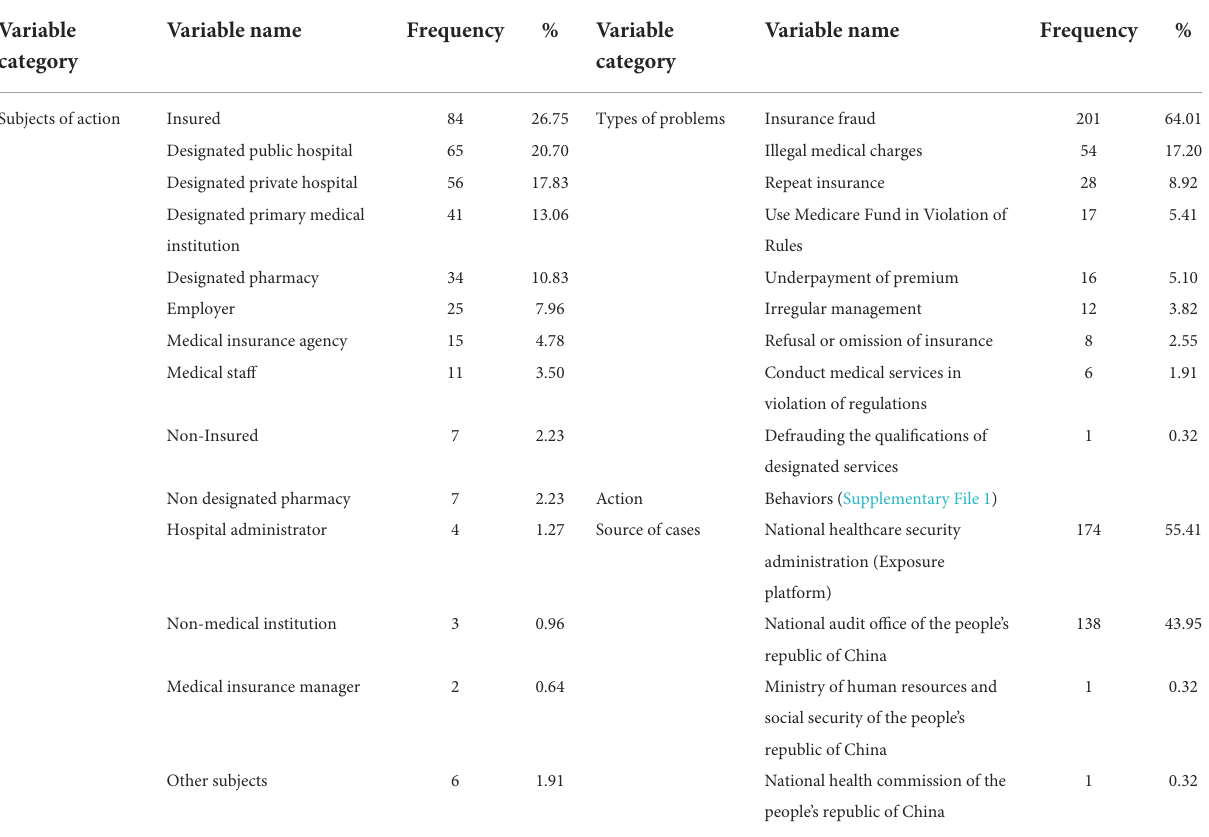
TABLE 1 Basic information of typical